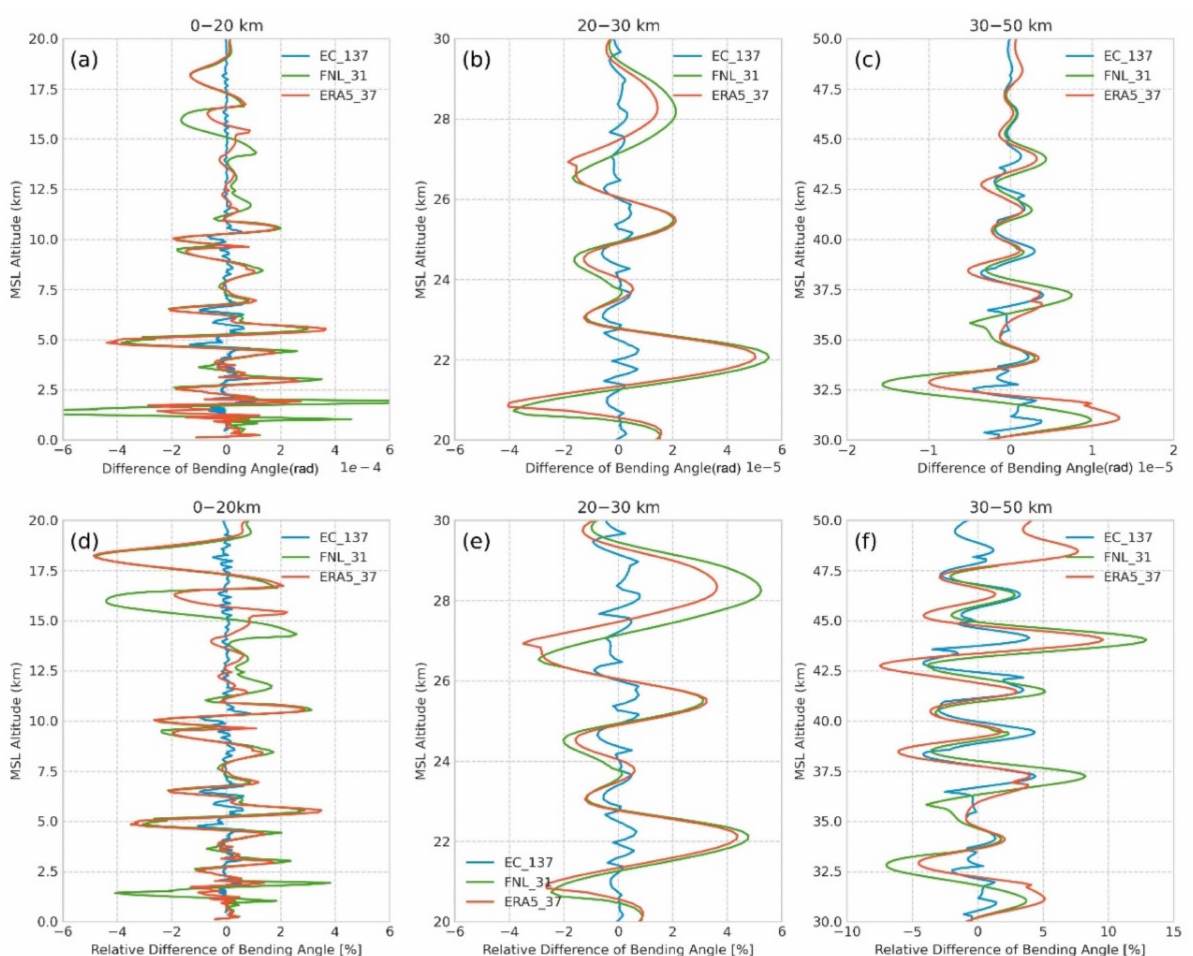
Figure A6. The same as Figure 7 but in log-linear interpolation, the difference ( a – c ) and RD ( d – f ) of FM based on the exp algorithm and log-linear interpolation. The BA RD of EC4Dvar below 35 km is less than ± 1%, whereas it of FNL and ERA5 below 35 km is less than ± 5%. Above 35 km, the RD EC4Dvar is less than ± 5%, while it of FNL and ERA5 is up to